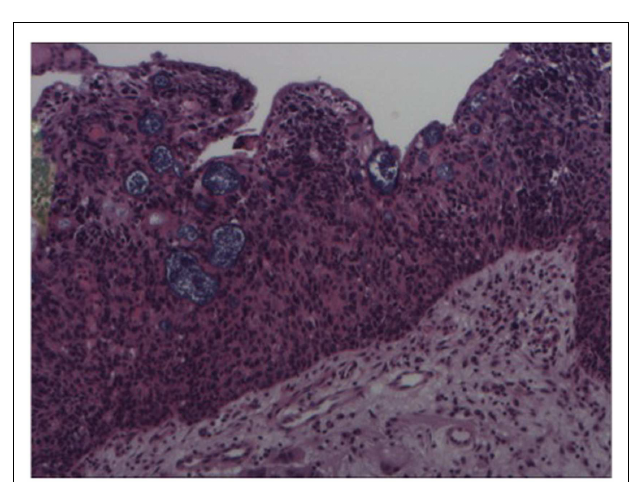
FIGURE 3 | Hematoxylin and eosin stain – high power of sinonasal inverted papilloma with infiltration of epithelium by atypical cells (esthesioneuroblastoma).